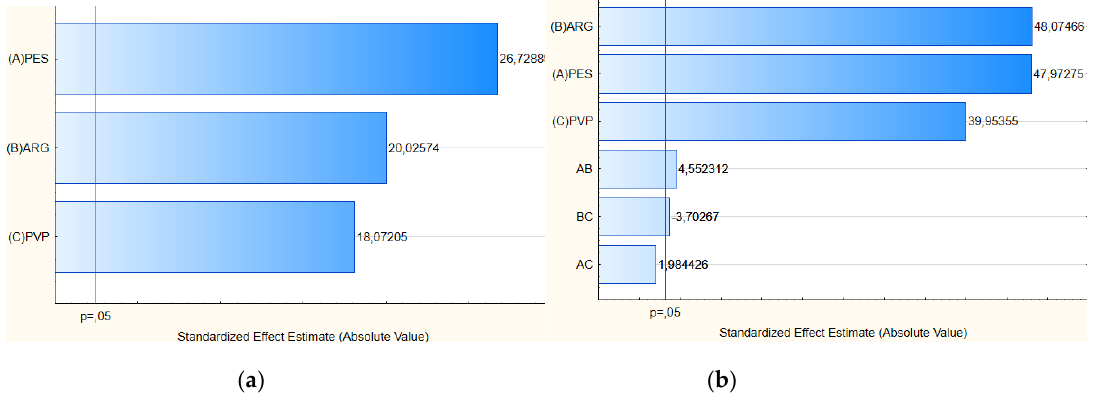
Table 6. Coded mathematical models: linear and quadratic for the contact angle. Model